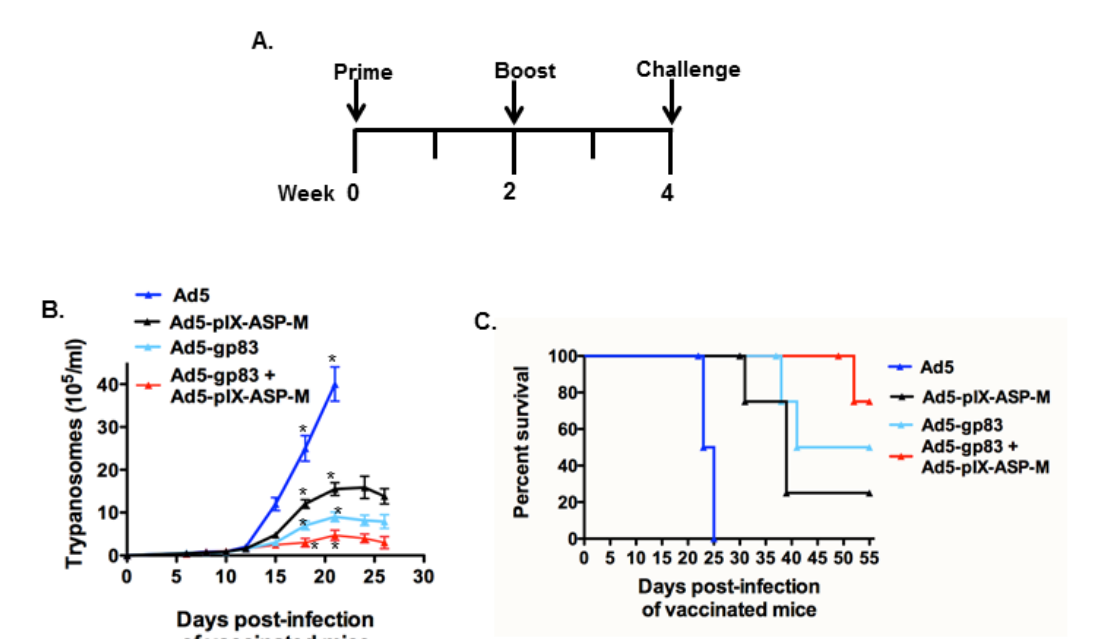
Figure 5. Immunization of mice with Ad5-pIX-ASP-M provides protection against challenge with T. cruzi , and this protection is significantly increased when mice are co-immunized with Ad5-pIX- ASP-M and Ad5-gp83. (A): Schedule of immunization and challenge with T. cruzi trypomastigotes. (B) Parasitemia of vaccinated mice with several vaccine Ad vector constructs. C3H/He mice (5 per group, 6-week-old) were immunized with Ad5, Ad5-pIX-ASP-M, Ad5-gp83 or with Ad5-gp83 + Ad5-pIX- ASP-M and challenged intraperitoneally with a lethal dose of blood trypomastigotes (5 × 10 3 ). The kinetics of parasitemia was determined in 5 µl of blood tail. Data represent the mean values ± SEM. The means are significantly different ( P < 0.0229) among the 4 groups at the times indicated by 1-way ANOVA. (C): Kaplan–Meier survival